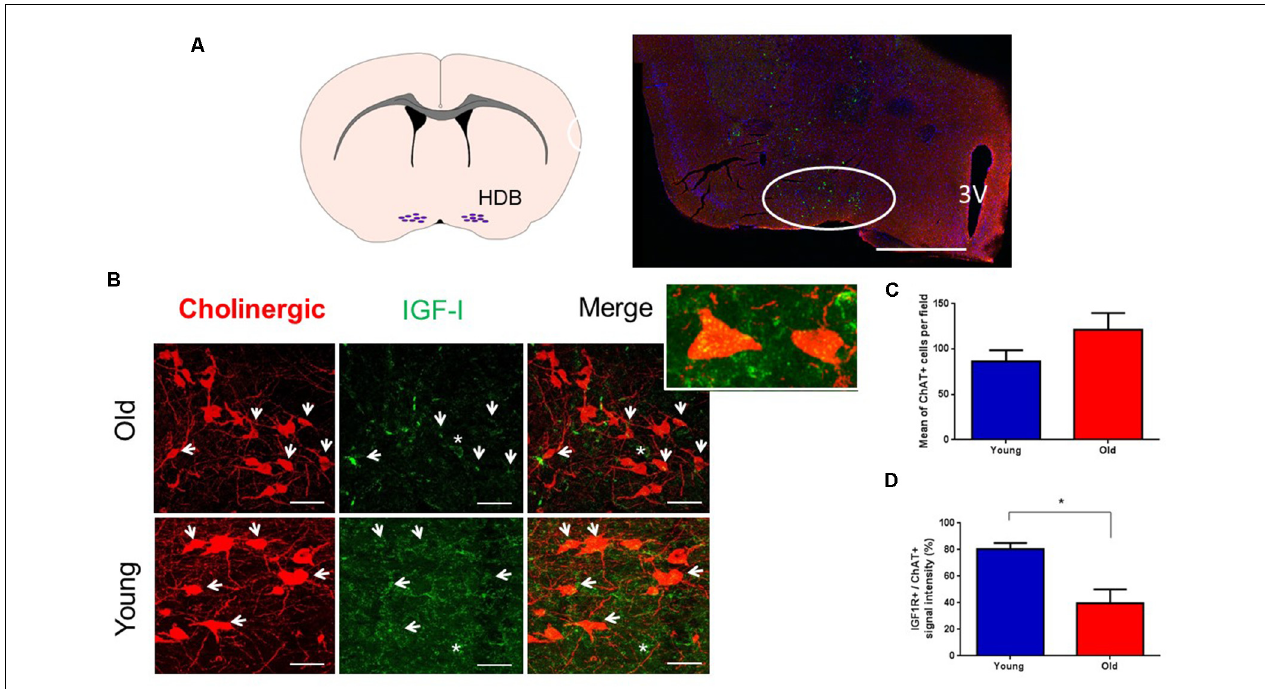
FIGURE 1 | Cholinergic neurons express IGF-I receptors. (A) A schematic figure and a representative photomicrograph of the BF showing HDB nucleus (circle) and the ventral putamen. In this case, ChAT+ neurons appear as small green points. (B) Photomicrographs of double immunocytochemistry in the HDB nucleus showing staining of cholinergic neurons (red) and IGF-IR (green) in young and old animals. Note the presence of abundant cholinergic fibers in the HDB area and that IGF-IR were expressed in cholinergic (arrows) and non-cholinergic cells (asterisk). Inset shows two ChAT+ cells. (C) Mean ChAT+ cell per field in young (86.56 ± 12.11) and old mice (121.2 ± 18.58; n = 3 per group; pictures per condition: young = 18, old = 13; p = 0.1324, Unpaired t -test). (D) Measure of IGF-IR+/ChAT+ cells; we observed differences between young (80.3% ± 4.66) and old mice (39.7% ± 10.33; n = 3 mice per group, * p < 0.05, Unpaired t -test). 3V: Third ventricle. Bar in (A) , 500 µ m; in (B) , 50 µ m. Abbreviations: BF, basal forebrain; HDB, horizontal diagonal band of Broca.